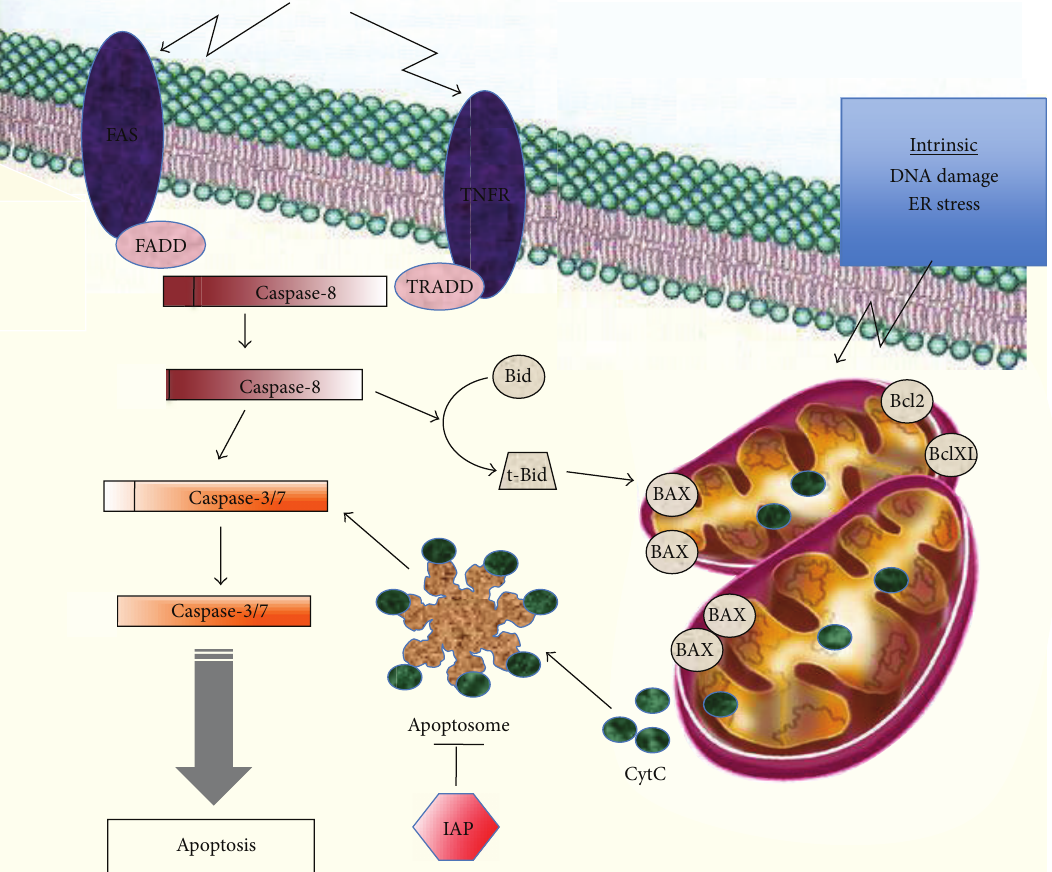
Figure 2: Intrinsic and extrinsic apoptotic pathways. Apoptosis can be triggered by the intrinsic mitochondrial pathway or through the extrinsic pathway involving the death receptors. The intrinsic apoptotic pathway is activated in response to various stimuli such as DNA damage, endoplasmic reticulum (ER) stress, or hypoxia. This pathway is mainly modulated through differential interactions between the antiapoptotic (Bcl-2, Bcl-XL), the proapoptotic (Bax, Bak), and the BH3-only proteins (Bad, Bid, Bim ... ). Bax, Bid, and Bim are initially inactive and must translocate to the mitochondria to induce apoptosis, either by binding via BH3 domains to Bcl-2, Bcl-XL and antagonizing their antiapoptotic functions or through the permeabilization of the mitochondrial membrane. Permeabilization of the mitochondrial membrane releases apoptogenic proteins, among which the cytochrome c is leading to the formation of the apoptosome, activation of caspase 9, and ultimately to the activation of effector caspases. In the extrinsic pathway, ligands (TNF, FASL, or TRAIL) bind to their specific death receptors, which lead to their oligomerization, recruitment of procaspase 8, and a specific adaptor protein (FADD and TRADD). The formation of the DISC induces autocatalysis of procaspase 8 into its active form, which in turn leads to the activation of the effector caspases.